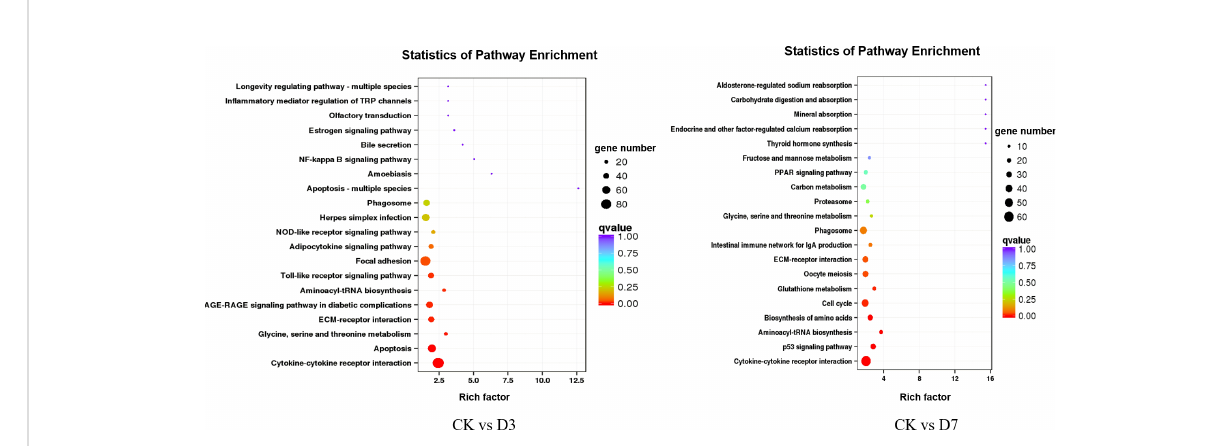
FIGURE 4 Scatterplot of the KEGG (Kyoto Encyclopedia of Genes and Genomes) pathway enrichment analysis. Rich factor represents the ratio of the number of DEGs and the number of all genes in the pathways.